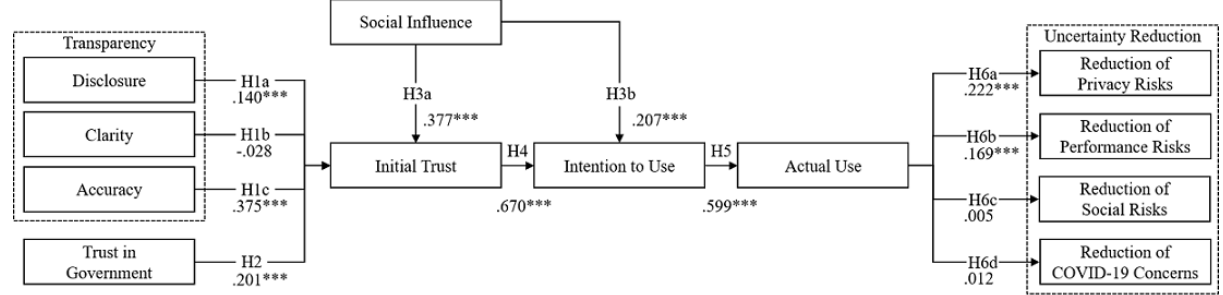
Figure 2. Results of structural equation model. H: hypothesis. *** P <.001.